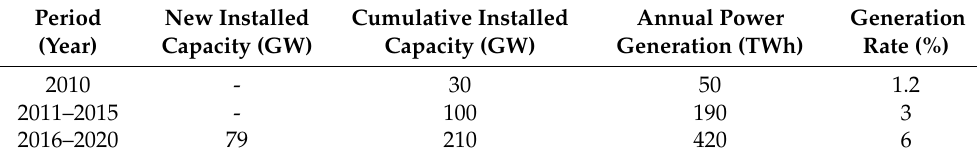
Table 3. Development goals of wind power in 2010s.